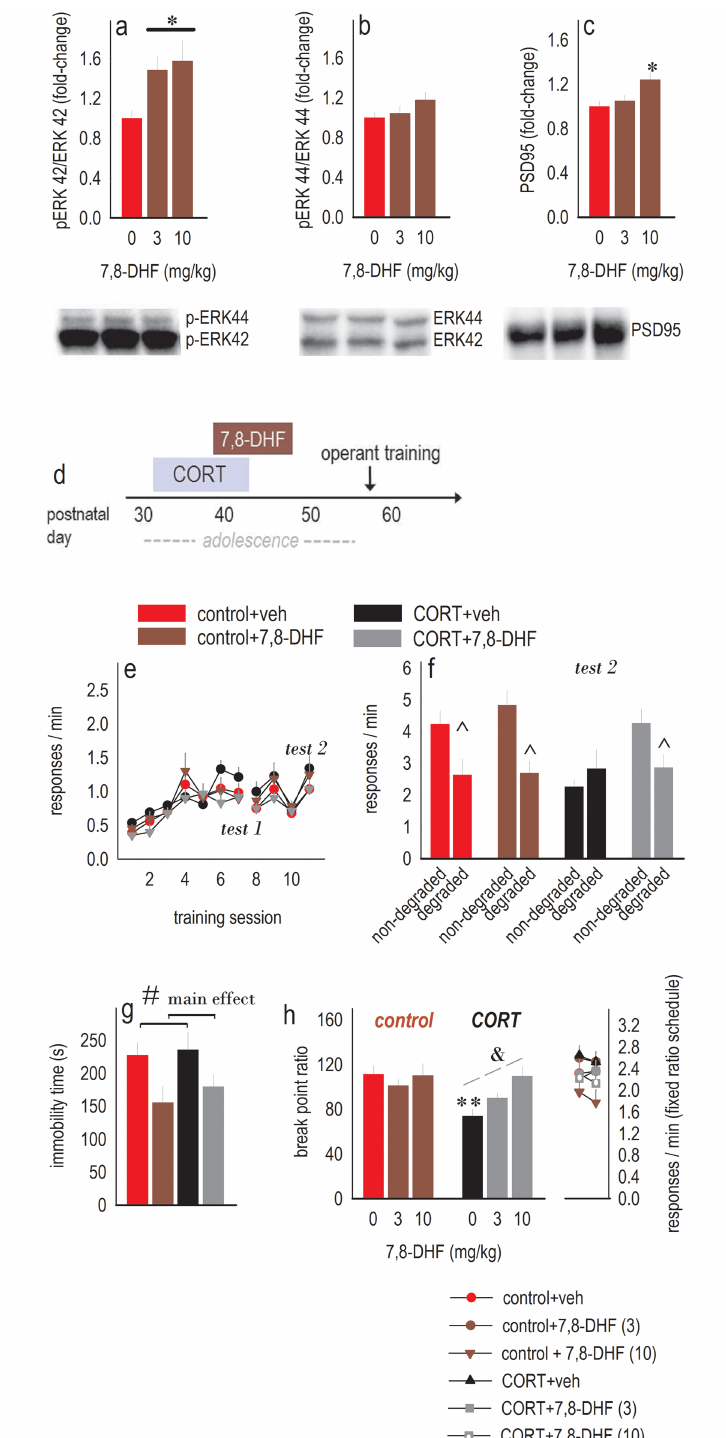
Fig 4. Durable blockade of CORT-induced habits and depression-like behavior. (a) Repeated7,8-DHF treatment increasedp-ERK42 in the vHC (b) but had no effects on p-ERK44.(c) At the highest dose tested, levels of the synapticmarker PSD95 were also increasedrelative to the control and 3 mg/kg groups. Representative blots are below. n = 9–14/group.(d) Experimental timeline.(e) Mice developedfood- reinforcedinstrumental responses without differences betweengroups. Responseacquisitioncurves